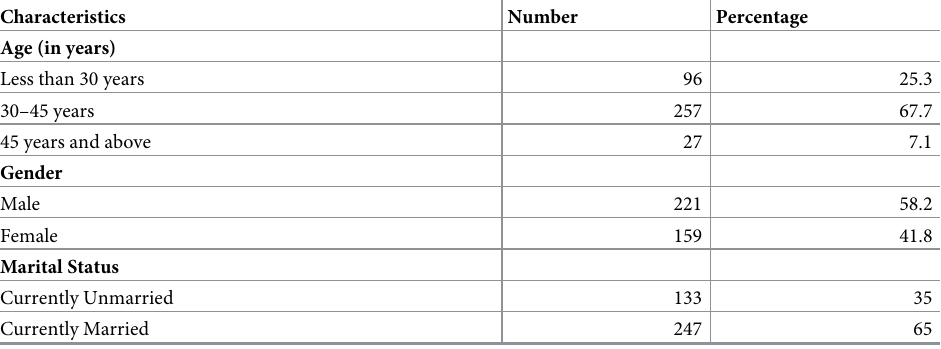
Table 2. Characteristics of the study